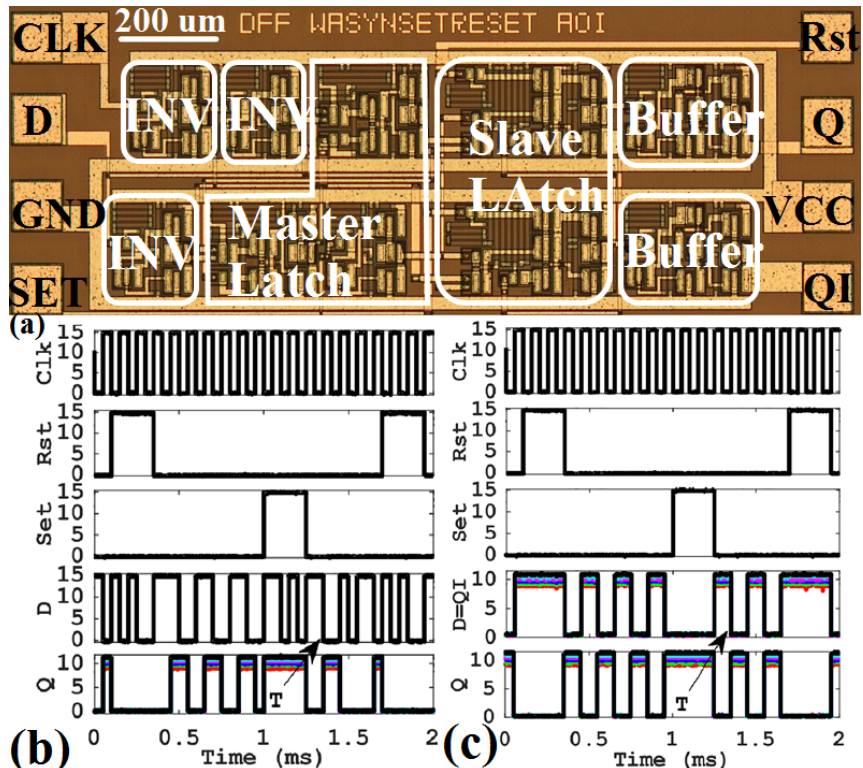
Figure 20. SiC TTL-based DFF with asynchronous active high set and reset ( a ) micro-photograph ( b ) measured transient response in the range of T = 25–500 ○ C, sampling the data D to Q at a positive edge of the clock ( f clk = 10 kHz with V IH = 15 V and V IL = 0 V) ( c ) measured transient response in the range of T = 25 to 500 ○ C, as a clock divider by connecting the QI to D with f clk = 10 kHz with V IH = 15 V and V IL = 0 V.